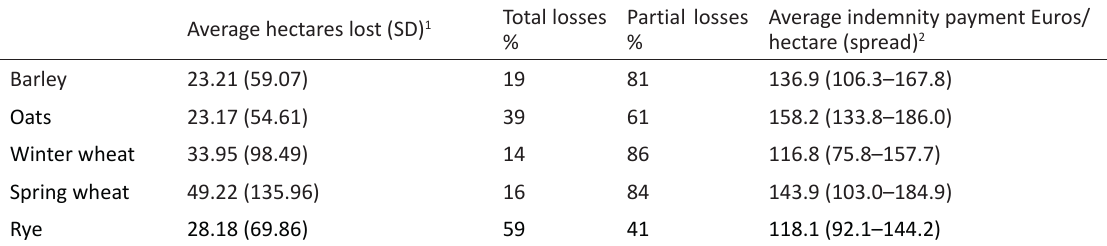
1 Average hectares lost = (hectares with total loss + hectares with partial loss)/cultivated area 2 Average indemnity payment in Euros: losses equivalent to 50% of the area reference yield. Lower limit: losses equivalent to 60% of the area reference yield. Upper limit: losses equivalent to 40% of the area reference